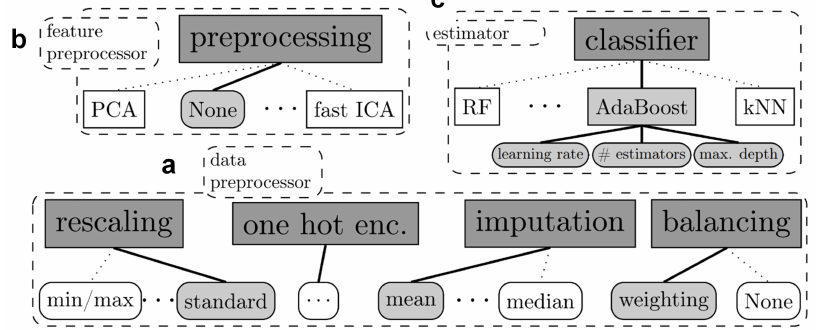
Figure 1. The Auto-Sklearn pipeline [12] contains three main building blocks: ( a ) Data preprocessor, ( b ) Feature preprocessor, and ( c ) Estimator or machine learning algorithms.